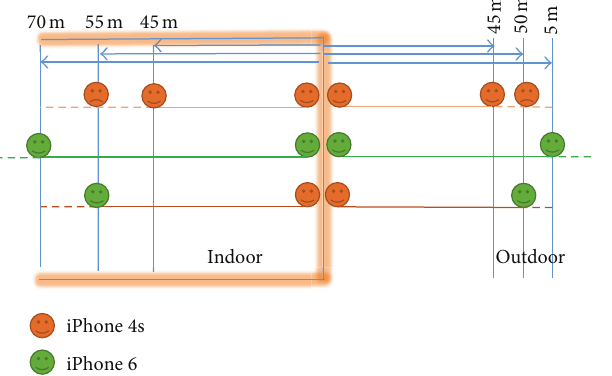
Figure 7: Connection distance experiment diagram.